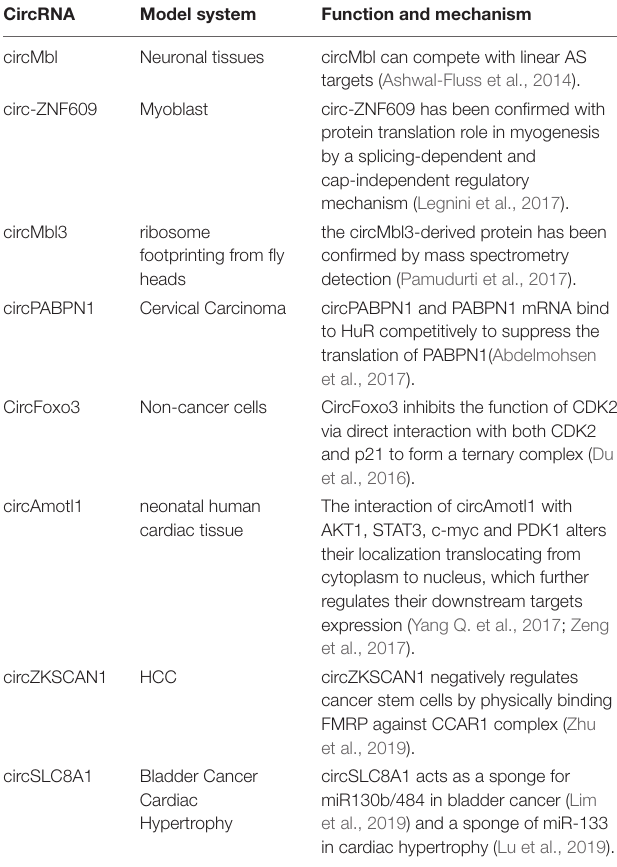
TABLE 1 | Regulatory mechanisms of circRNAs on biological functions.